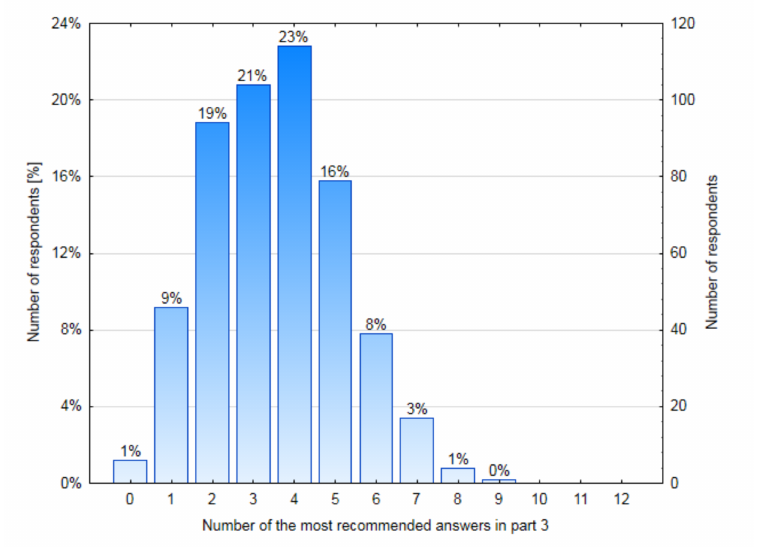
Figure 2. The number of the most recommended answers to questions in part 3 of the survey. The respondents’ reactions to scenarios and ability to correctly assess road